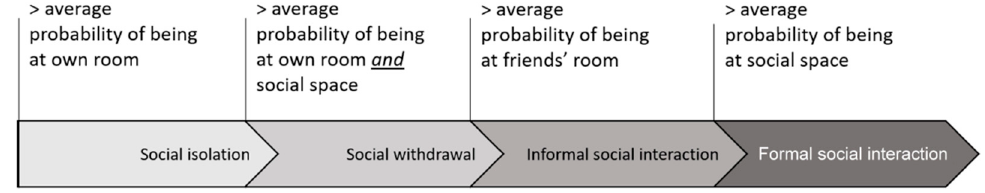
Figure 2. Definition of social behaviour.